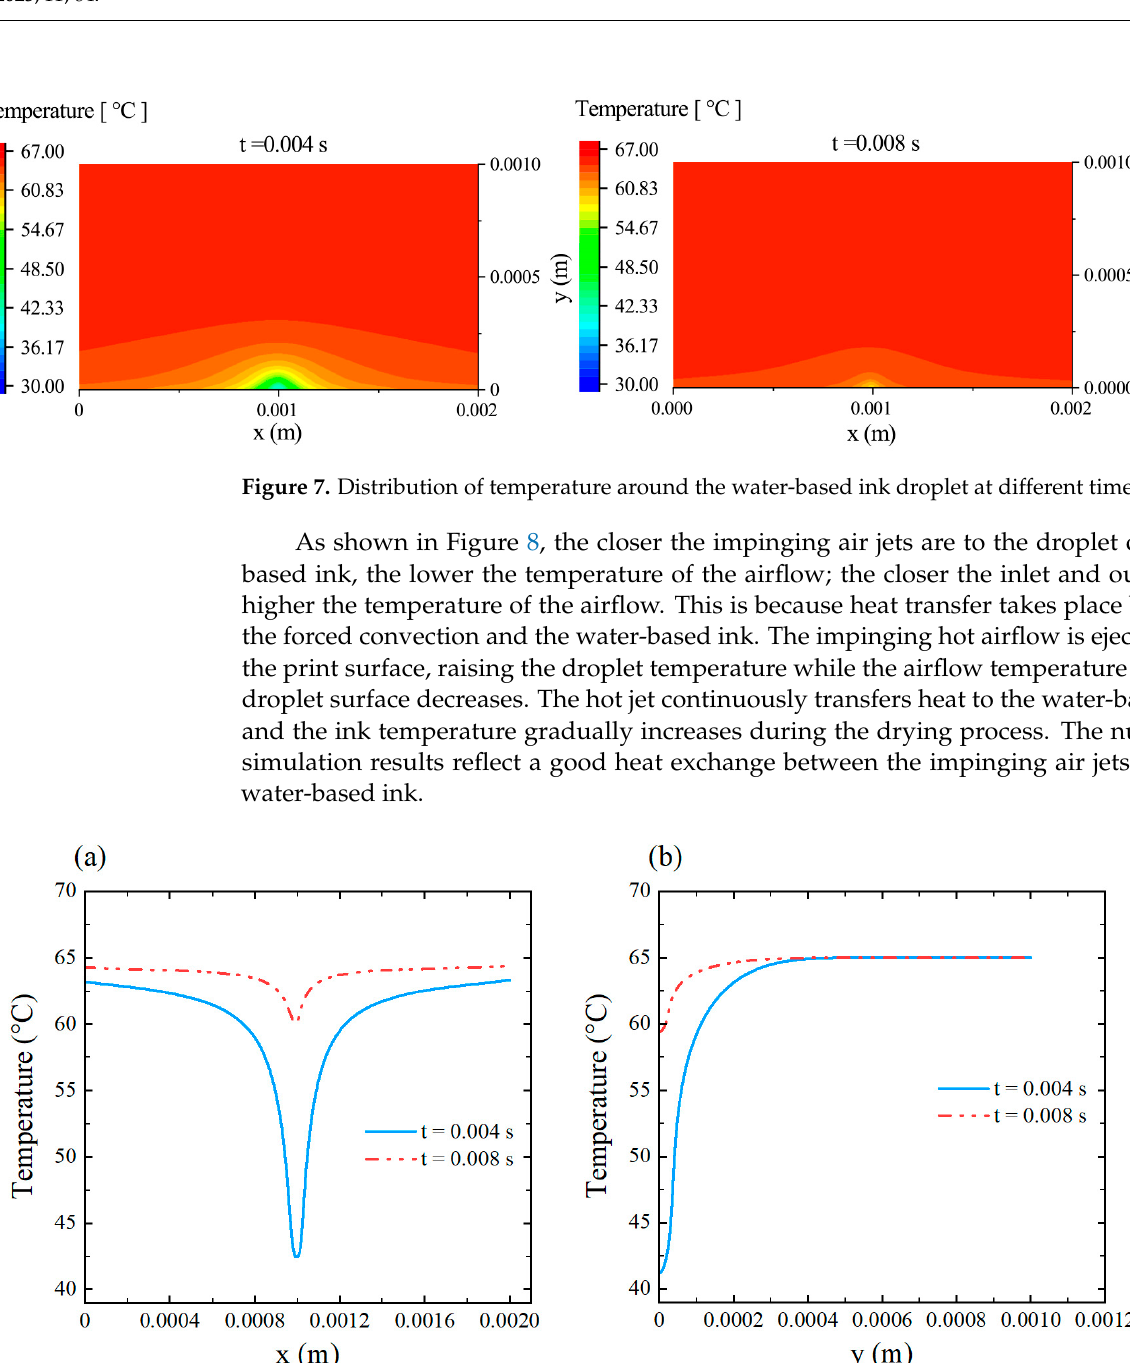
Figure 9. Variation in drying time with velocity for water-based ink ( T air = 70 °C).